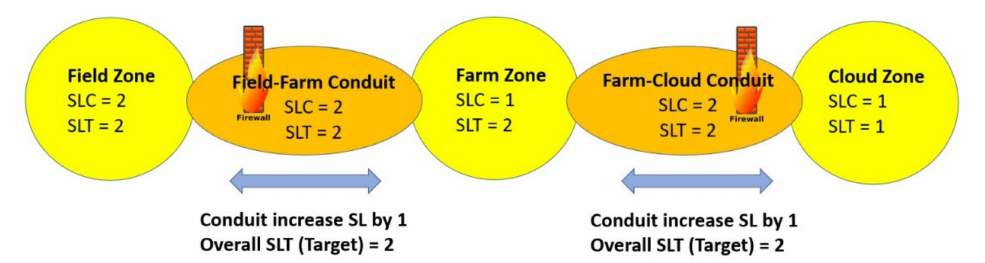
Figure 8. Zones and conduits concept with a zone embedding example.